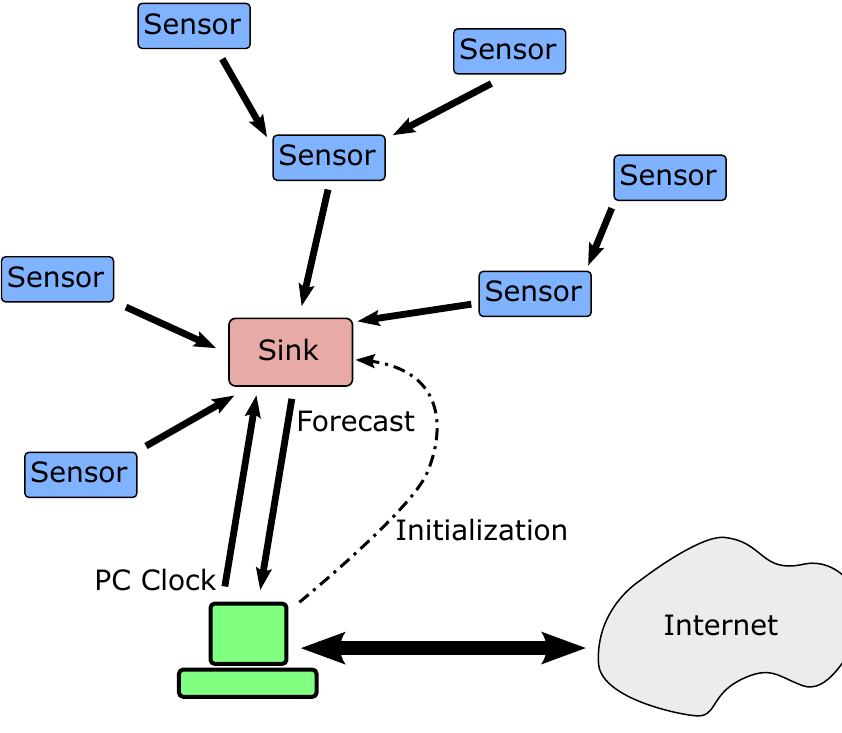
Figure 1. Wireless sensor network